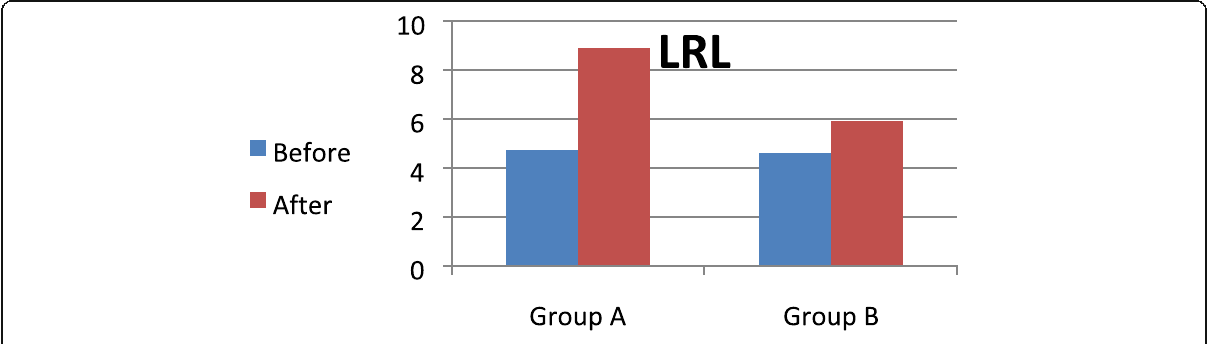
Fig. 1 Scores of LRL pre and post treatment within each group. LRL, logical reasoning level